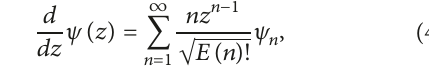
in terms of |𝑧| 퐸